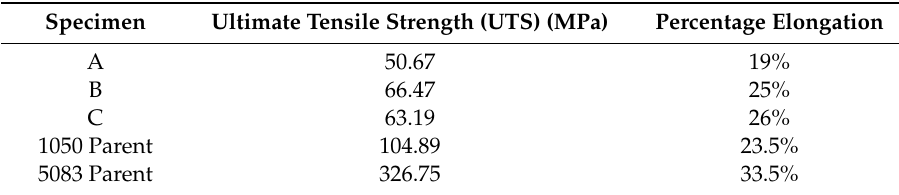
Table 3. Tensile test